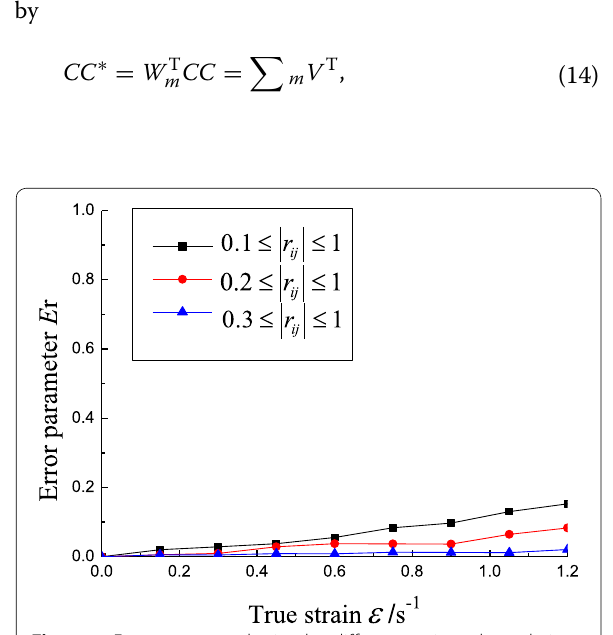
Figure 5 Eror parameter obtained at different strain and correlation coefficient values during grain boundary